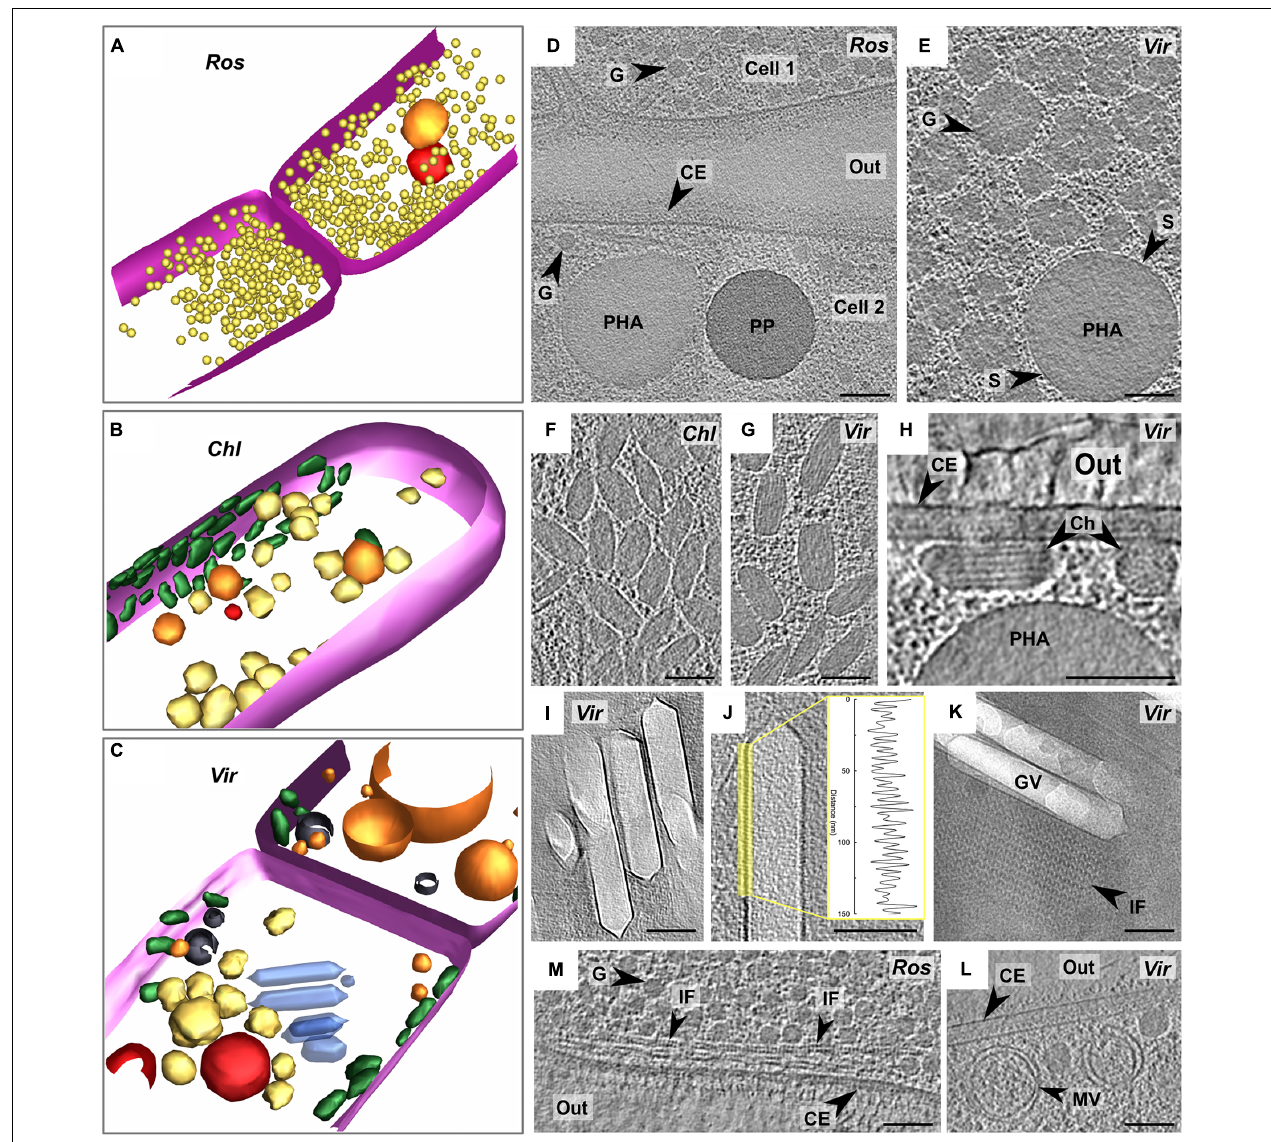
FIGURE 4 | Segmentation of tomograms of R. castenholzii (A) , C. aggregans (B) , and “ Ca . Viridilinea mediisalina” (C) : pink – cytoplasmic membrane, orange – polyhydroxyalkanoate granule, red – polyphosphate granule, yellow – third type of granule, green – chlorosomes, blue – gas vesicles, black – membrane vesicles. Marking of the strains on the images: R. castenholzii (Ros), C. aggregans (Chl), and “ Ca . Viridilinea mediisalina” (Vir). Intracellular granules on slices through tomograms of R. castenholzii (D) and “ Ca . Viridilinea mediisalina” (E) . Chlorosomes under CM on slices (top view) through tomograms of C. aggregans (F) and “ Ca . Viridilinea mediisalina” (G) . Chlorosomes on slices (cross section view) through tomogram of “ Ca . Viridilinea mediisalina” (H) . Gas vesicles on slices through tomogram of “ Ca . Viridilinea mediisalina” (I,J) and density profile of the vesicles membrane. Gas vesicles and sheet of intracellular filaments on CryoEM image (K) . Intracellular filaments on slices through tomogram of R. castenholzii (M) . Intracellular vesicles on slices through tomogram of “ Ca . Viridilinea mediisalina” (L) . In, cytoplasm in a cell; out, extracellular space; CE, cell envelope; Ch, chlorosome; G, third type of granule; GV, gas vesicle; IF, intracellular filaments; MV, membrane vesicle; PHA, polyhydroxyalkanoate granule; PP, polyphosphate granule; S, surface of polyhydroxyalkanoate granules. Bars: 100